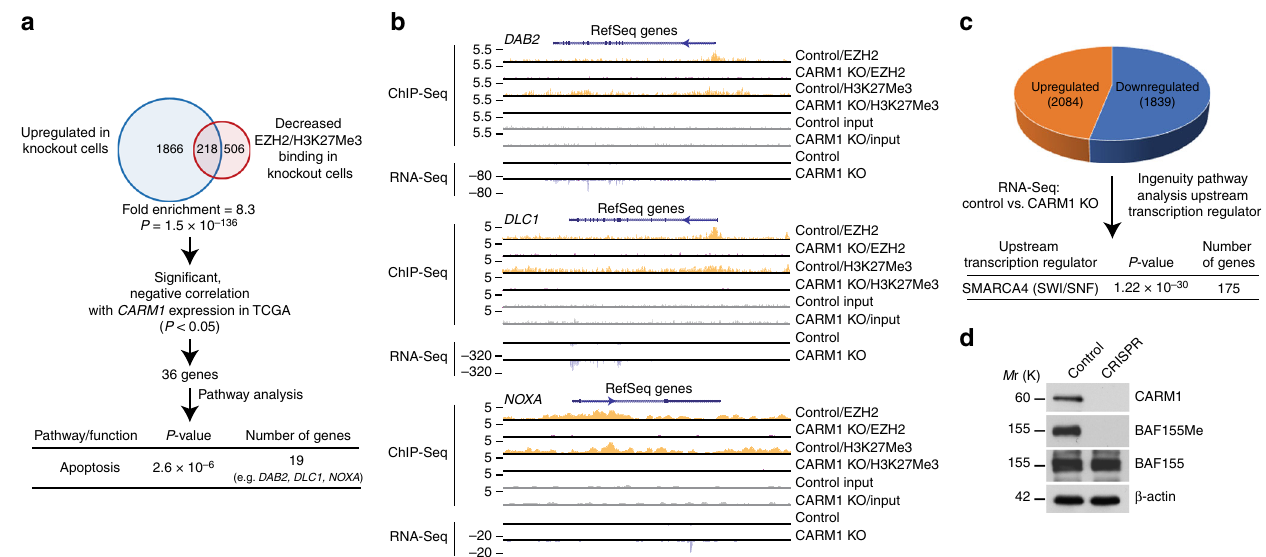
Fig. 3 CARM1 promotes the silencing of EZH2 target genes and CARM1-regulated genes are enriched for SWI/SNF target genes. a Experimental strategy used to identify CARM1-regulated, clinically relevant EZH2/H3K27Me3 target genes. Ingenuity Pathway Analysis revealed that the top pathway enriched for the identi fi ed CARM1-regulated EZH2/H3K27Me3 target genes was apoptosis. Speci fi cally, 19 of the 36 identi fi ed genes (including DAB2 , DLC1 , and NOXA ) are known to promote apoptosis (see full list in Supplementary Table 2). b Examples of EZH2 and H3K27Me3 ChIP-seq and RNA-Seq tracks of the newly identi fi ed CARM1-regulated EZH2/H3K27Me3 target genes in the indicated parental control and CARM1 knockout A1847 cells. c Differentially expressed genes in control parental and CARM1 knockout A1847 cells identi fi ed by RNA-Seq ( > 3-fold) were subjected to Ingenuity pathway analysis for upstream regulators. The analysis revealed that SMARCA4 (also known as BRG1, a catalytic subunit of the SWI/SNF complex) was the top